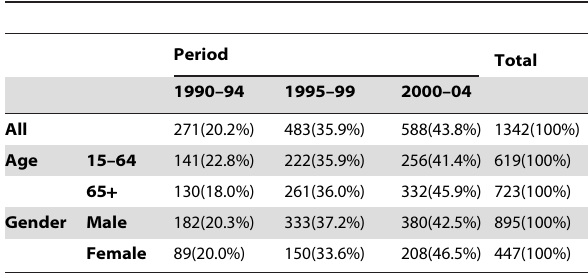
Table 1. Number of patients of CLL in Taiwan by age groups, genders, and time